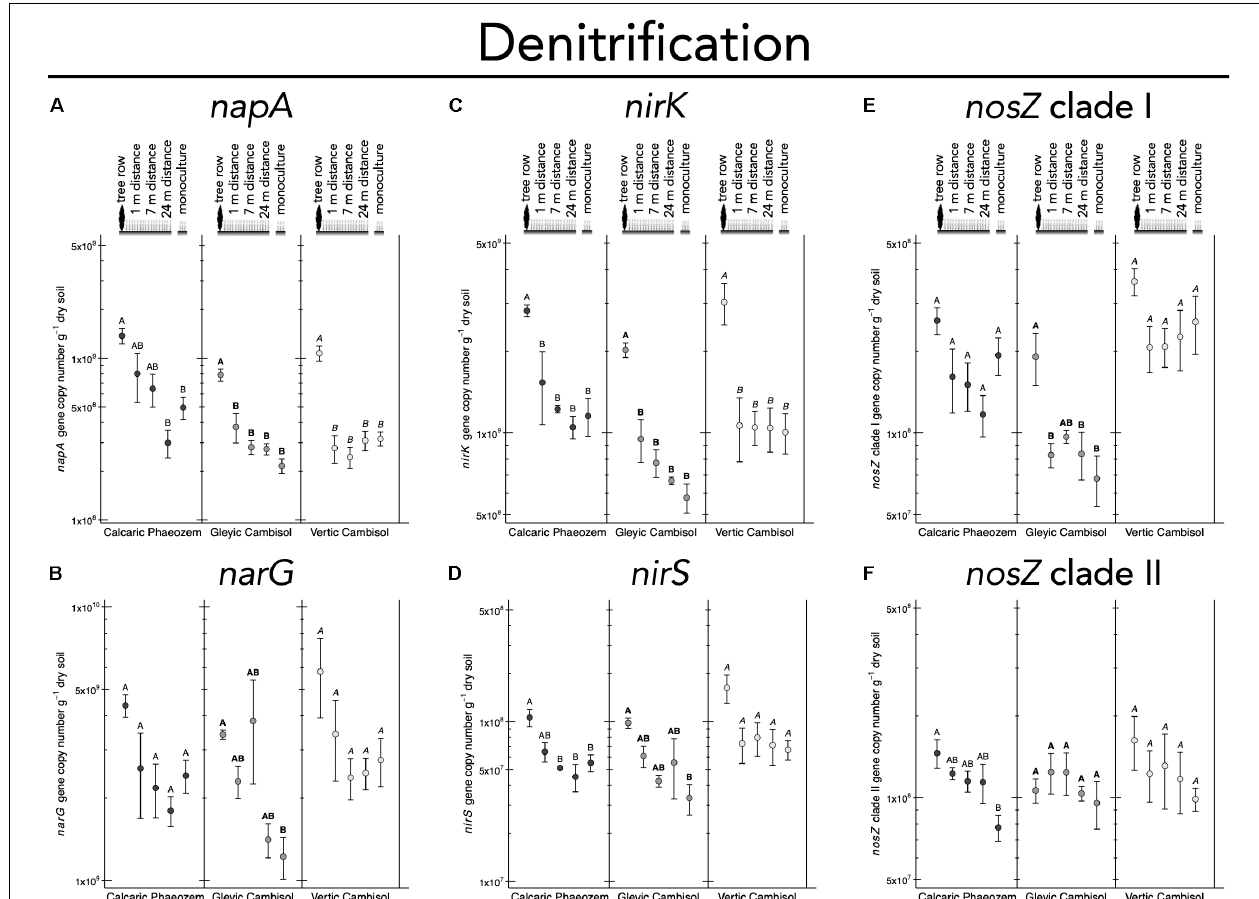
FIGURE 6 | Gene abundance of (A) napA , (B) narG , (C) nirK , (D) nirS , (E) nosZ clade I, and (F) nosZ clade II in soil of three paired temperate agroforestry and monoculture cropland systems. Means (bars are standard errors; n = 4) with different uppercase letters indicate statistically significant differences among the sampling locations (the tree row, 1, 7, and 24 m within the crop row of the agroforestry and the monoculture croplands) within one soil type (one-way ANOVA with Tukey’s HSD test of log 10 -transformed data at p <